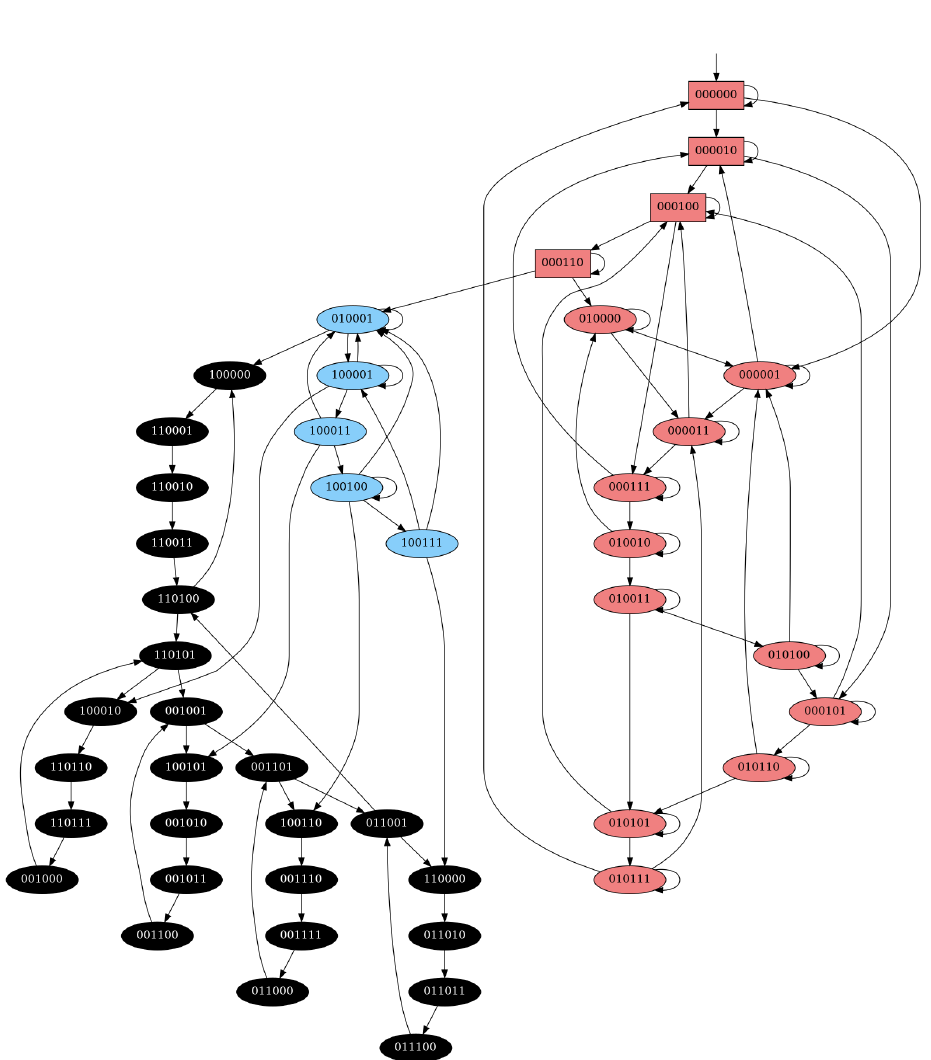
Figure 8: State transition graph of AES IP core obfuscated with Dynamic State Deflection (including HARPOON ). Tarjan’s algorithm splits all states into 3 strongly connected components: obfuscation mode of HARPOON (marked in red), black hole cluster states (marked in black), and original FSM (marked in blue). Rectangle nodes mark the sequence from initial state 000000 to the original initial state 010001. Input values for each state transition are deliberately left out for